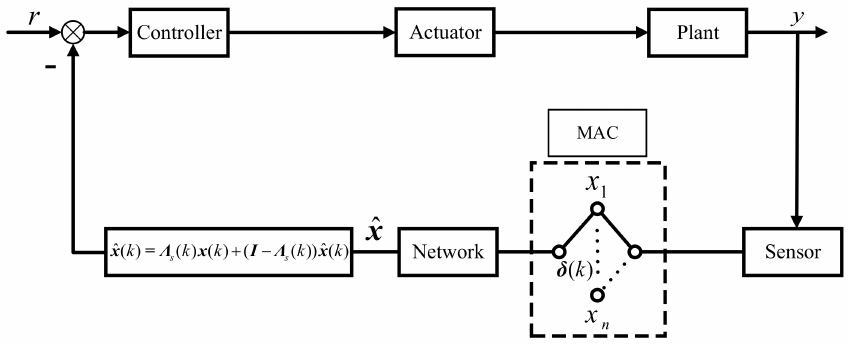
Figure 3. NCS with the MAC and the zero-order